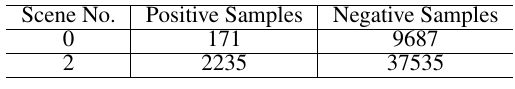
Table 3. Training